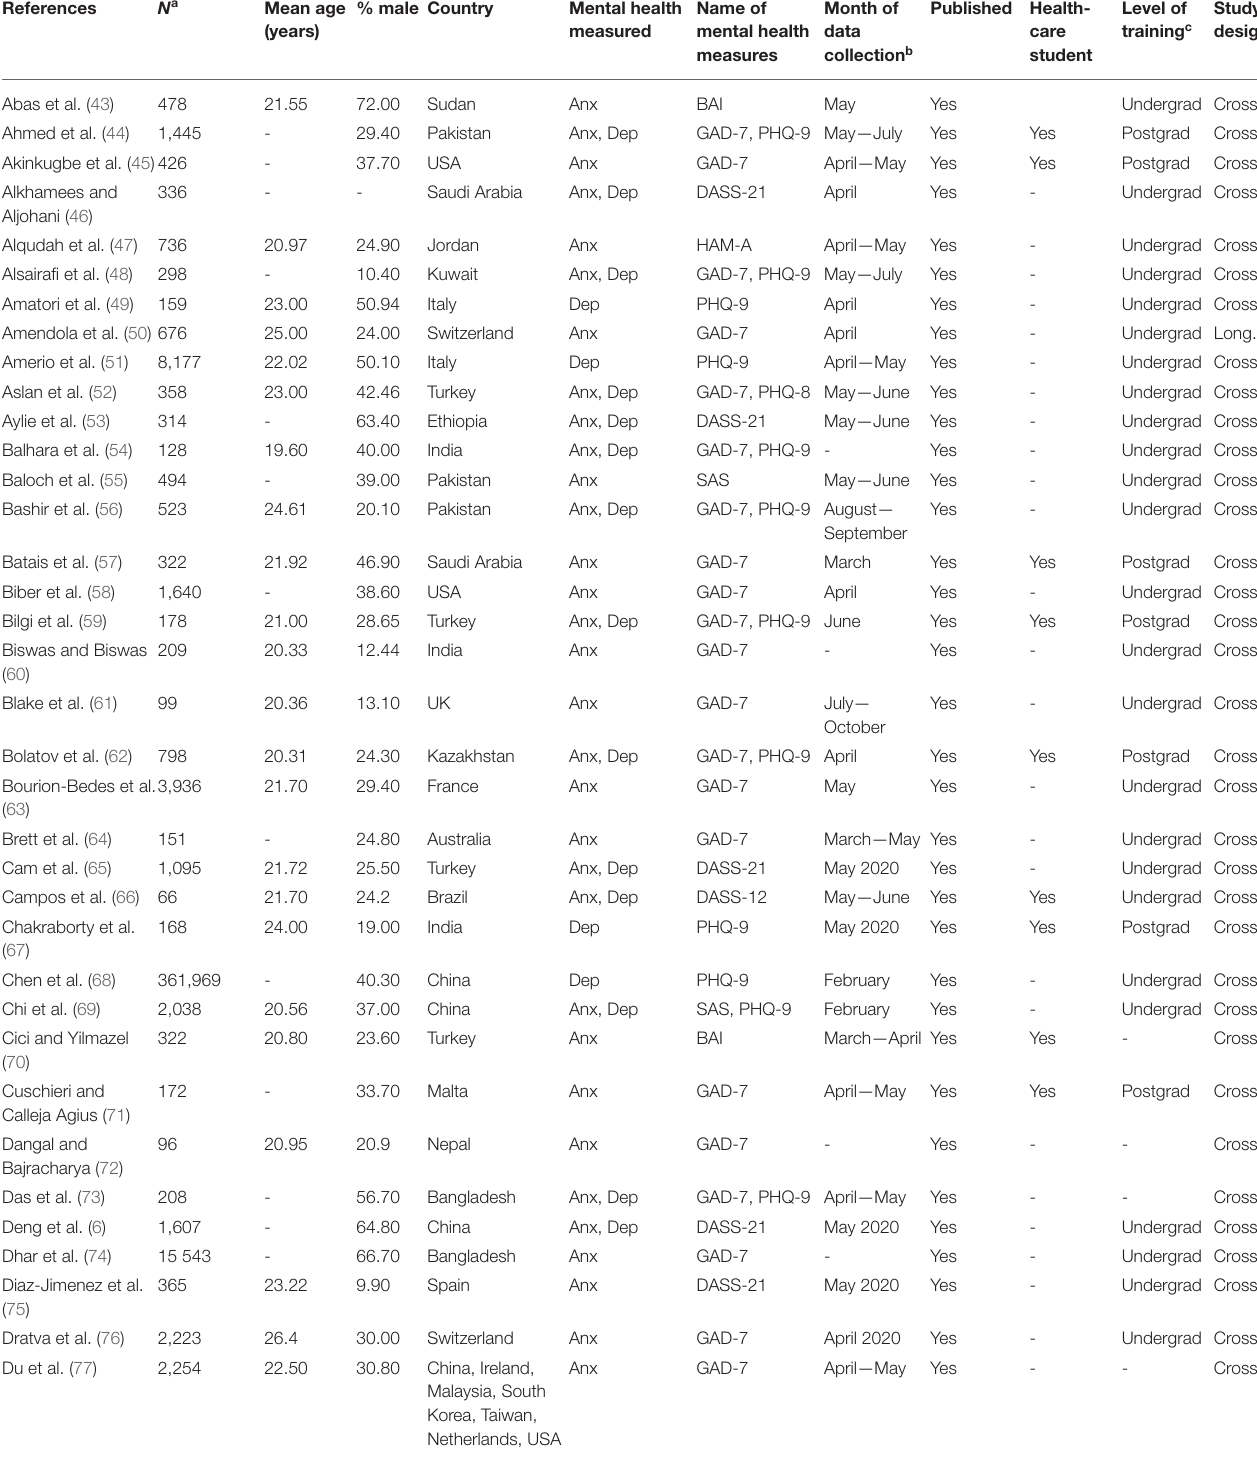
TABLE 1 | Characteristics of studies